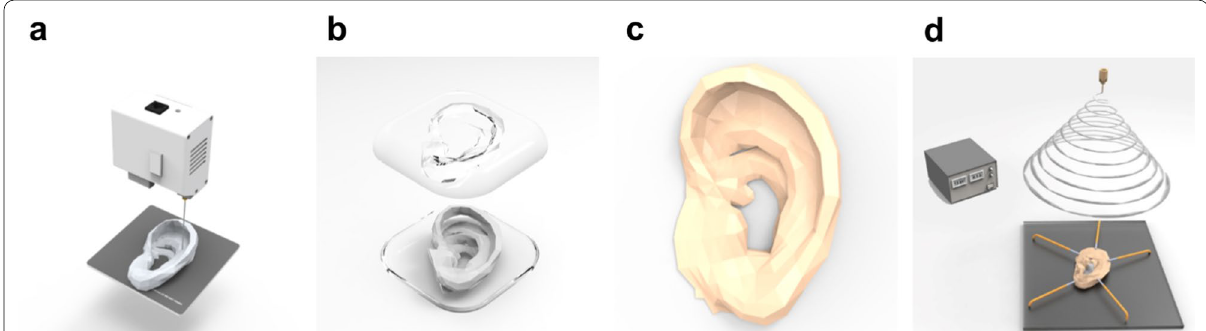
Fig. 1 Schematized process of conformal fabrication of an electrospun nanofiber mat on a 3D ear cartilage-shaped hydrogel collector. a The 3D printing process for the 3D ear cartilage-shaped template. b The PDMS negative mold replicated by the 3D ear-cartilage-shaped template. c The alginate–gelatin hydrogel collector with the shape of the ear cartilage. d Conformal fabrication of an electrospun nanofiber mat with the flattened 3D ear cartilage-shaped hydrogel